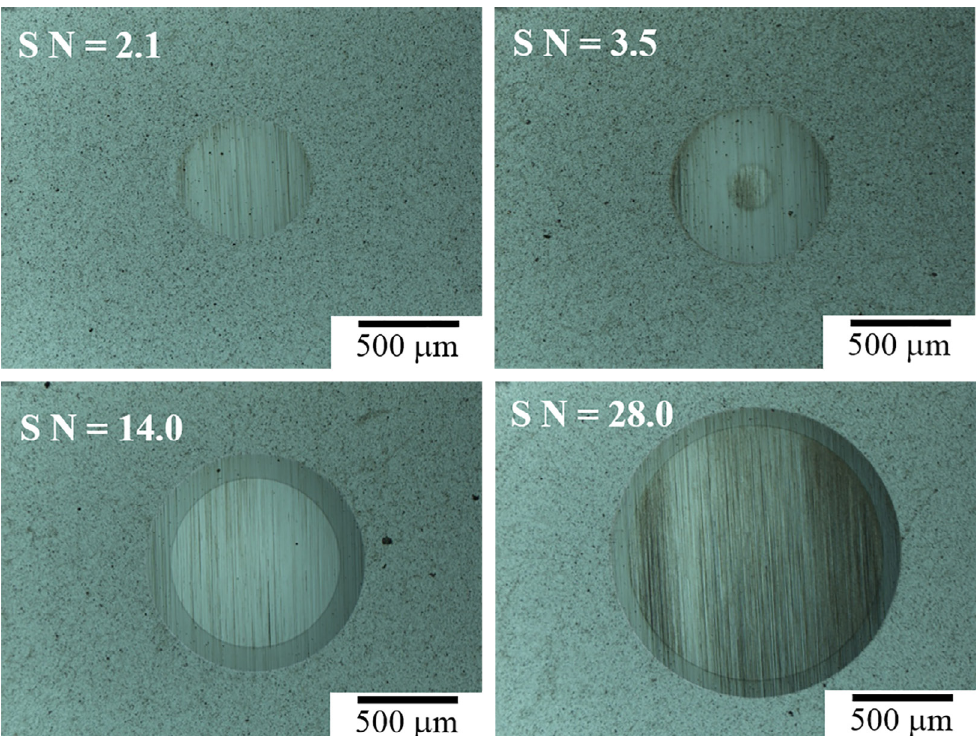
Figure 10. Micrographs of the produced wear scars after various test